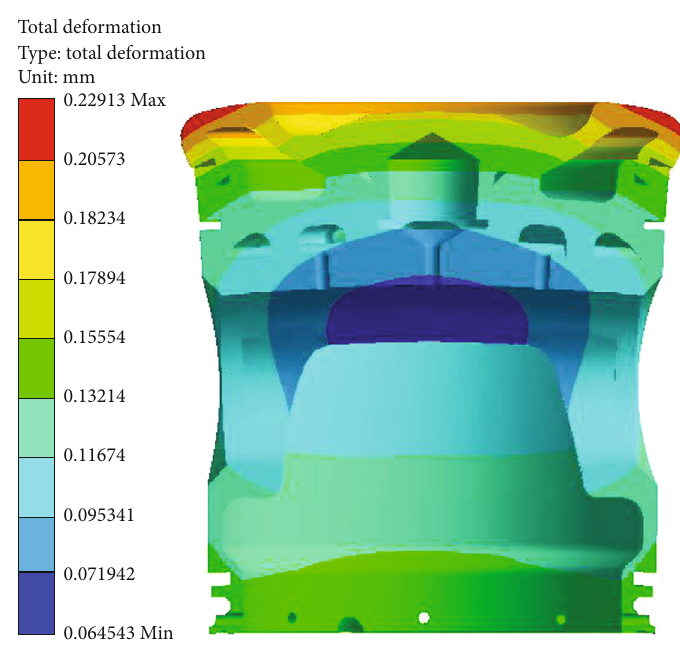
Figure 10: The deformation nephogram of the piston under thermomechanical stress coupling Figure 14, the deformation of A and B no longer presents by the red line in Figure 14. Friction between the pin and an oval shape but a regular round shape. The radius value the pin bore leads to an oval shape on A and B of the pin of B is about 0.002 mm larger than A, which is mainly bore. When the new design scheme is adopted, the defor- because the stress on main force surface is di ff erent from mation of A and B has been greatly improved compared the thrust surface under the reciprocating piston e ff ect. with the previous one. As shown by the blue line in